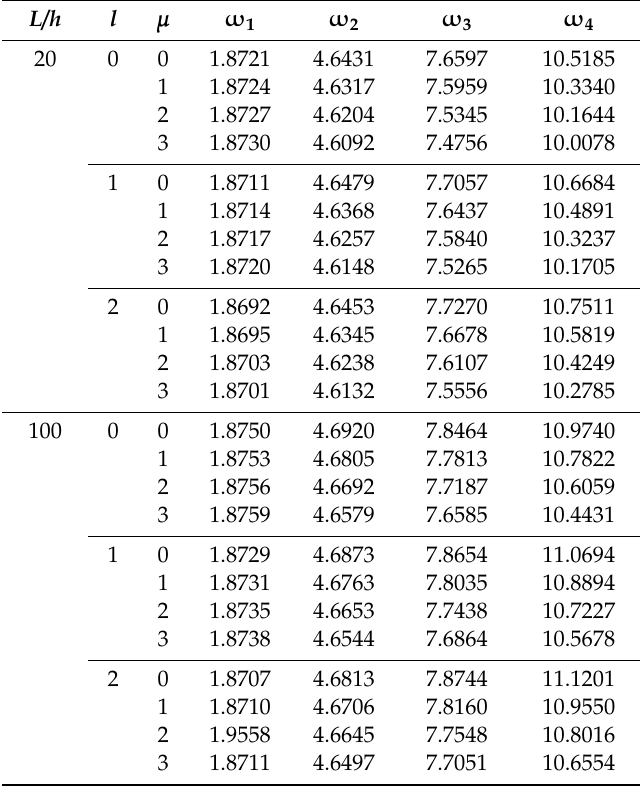
Table 7. E ff ect of the L / h and small-scale parameters on the natural frequencies for a clamped-free cantilever triclinic nanobeam.